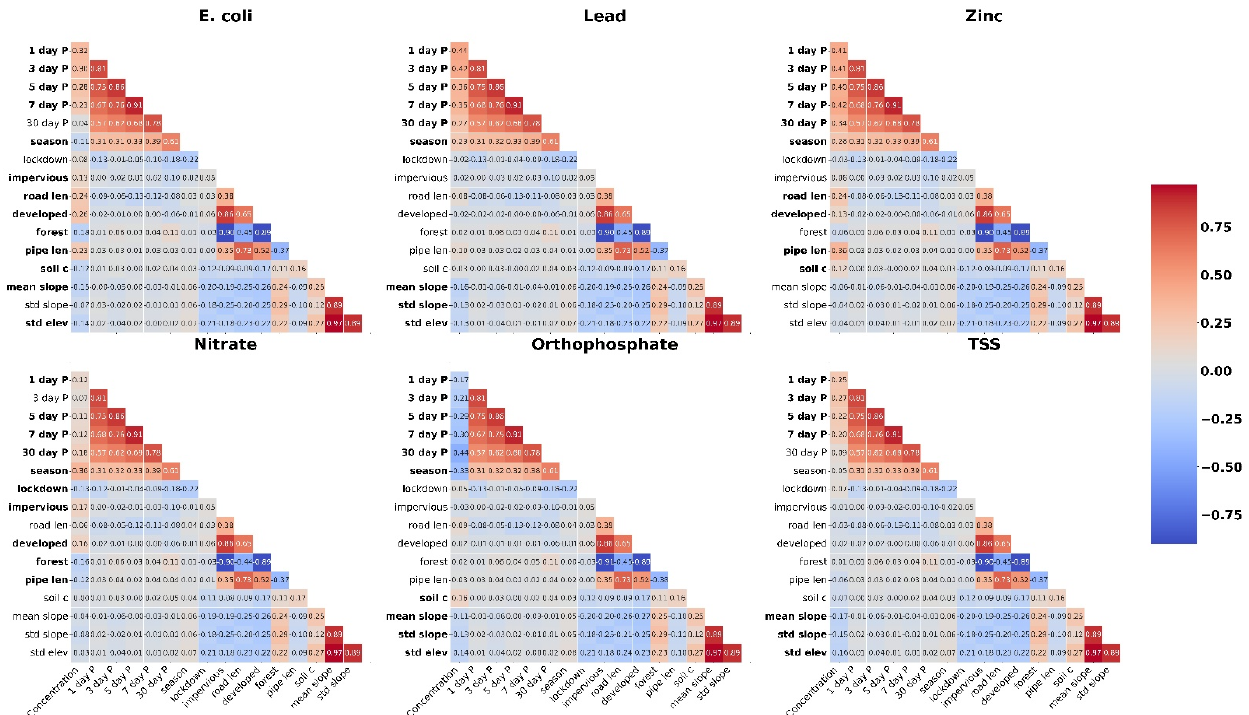
Figure 4. Spearman’s rank correlation coefficient values among pollutant concentrations and explana- tory variables. Statistically significant variables are shown in